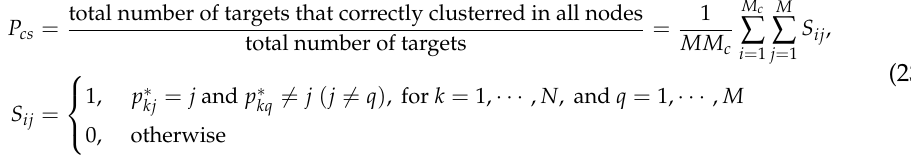
Figure 4. PCS ( a ) and NRMSE ( b ) vs. the number of initial anchor nodes ( K ) under σ w = σ v = 5 (deg) with N = σ u im im